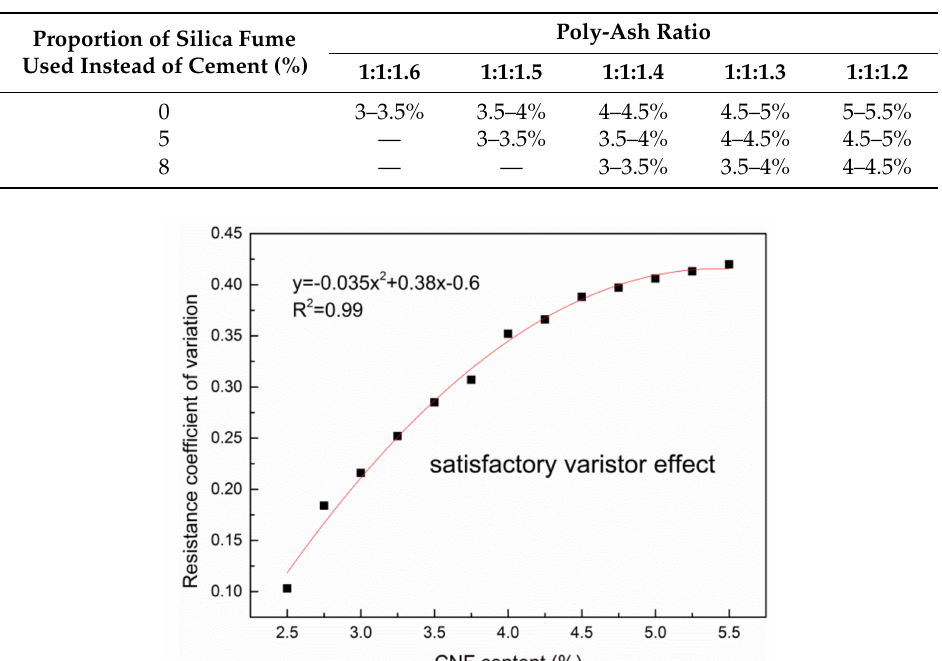
Table 8. Optimal blending ratio of CNF.